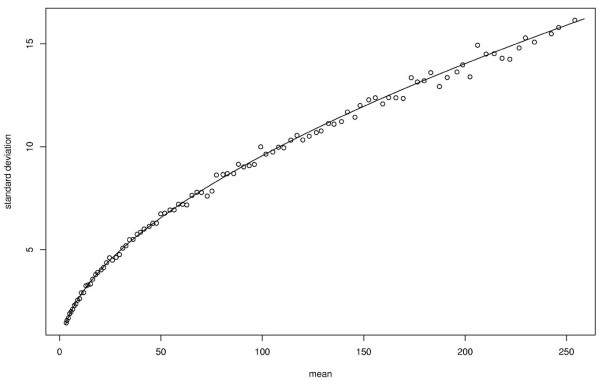
Comparison of σ and σ^
 MathType@MTEF@5@5@+=feaafiart1ev1aaatCvAUfKttLearuWrP9MDH5MBPbIqV92AaeXatLxBI9gBaebbnrfifHhDYfgasaacH8akY=wiFfYdH8Gipec8Eeeu0xXdbba9frFj0=OqFfea0dXdd9vqai=hGuQ8kuc9pgc9s8qqaq=dirpe0xb9q8qiLsFr0=vr0=vr0dc8meaabaqaciaacaGaaeqabaqabeGadaaakeaaiiGacuWFdpWCgaqcaaaa@2E86@. σ^
 MathType@MTEF@5@5@+=feaafiart1ev1aaatCvAUfKttLearuWrP9MDH5MBPbIqV92AaeXatLxBI9gBaebbnrfifHhDYfgasaacH8akY=wiFfYdH8Gipec8Eeeu0xXdbba9frFj0=OqFfea0dXdd9vqai=hGuQ8kuc9pgc9s8qqaq=dirpe0xb9q8qiLsFr0=vr0=vr0dc8meaabaqaciaacaGaaeqabaqabeGadaaakeaaiiGacuWFdpWCgaqcaaaa@2E86@ is estimated with a sample of size 1 000 and Nobs takes its values from 900 to 1 900. The solid line represents the theoretical values and the circles the empirical ones. The statistic S is used on the x-axis. n = ℓ = 10 000.